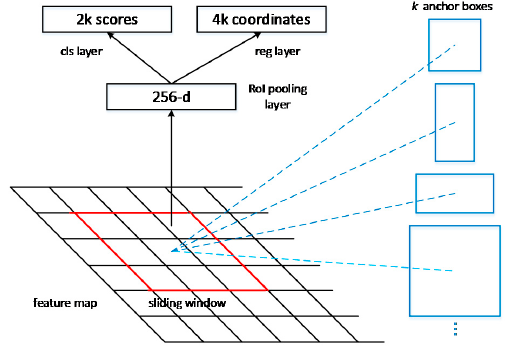
Figure 4. Architecture of the region proposal network (RPN). Table 2. Options for Anchor boxes.